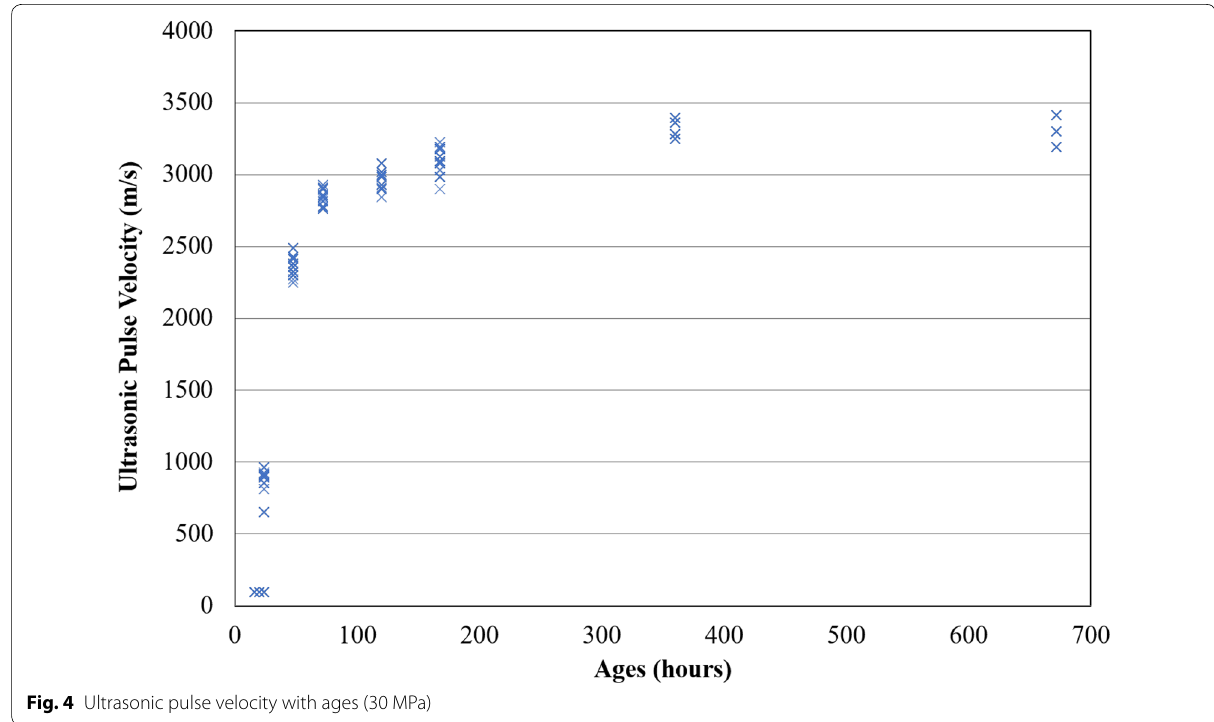
Fig. 4 Ultrasonic pulse velocity with ages (30 MPa)